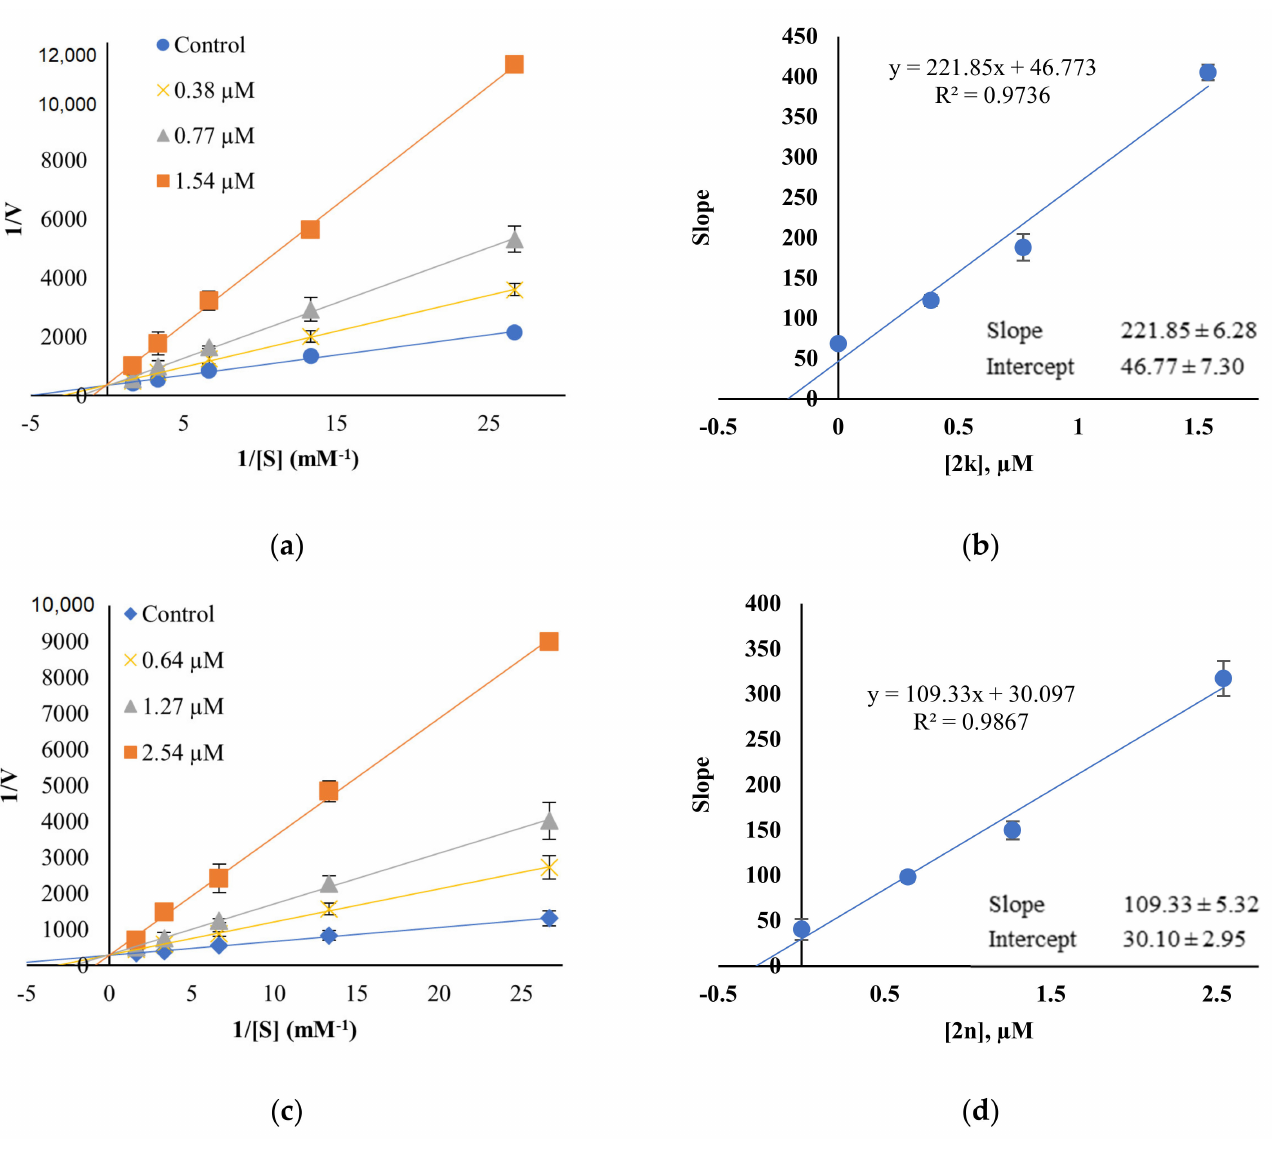
Figure 4. Lineweaver–Burk plots ( a , c ) and their secondary plots ( b , d ) of 2k and 2n for MAO-B, respectively. Five concentrations of benzylamine used were 0.0375, 0.075, 0.15, 0.3 and 0.6 mM, respectively, and three concentrations of inhibitor were ~1/2 × , 1 × , and 2 × IC 50 : 0.38, 0.77, and 1.54 µ M for 2k ; 0.64, 1.27, and 2.54 µ M for 2n . The K m value for MAO-B was 0.20